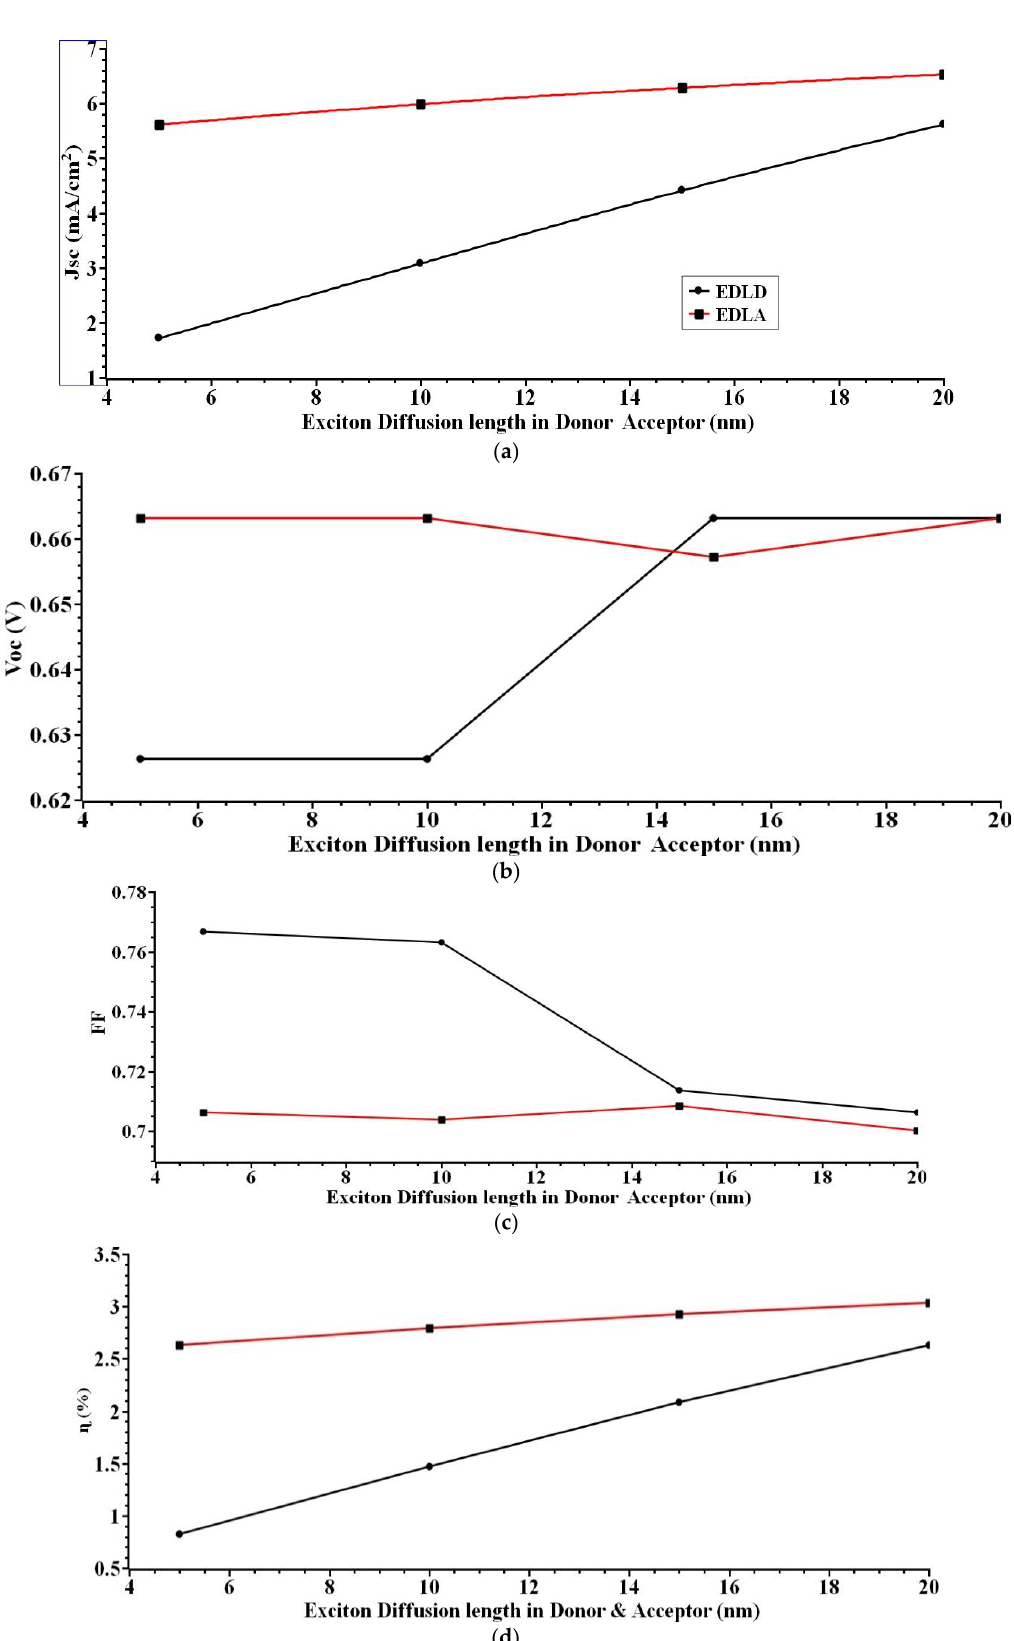
Figure 6. ( a ) J sc ( b ) V oc ( c ) FF ( d ) ɳ . Illustrates the output extracted for various exciton diffusion lengths.